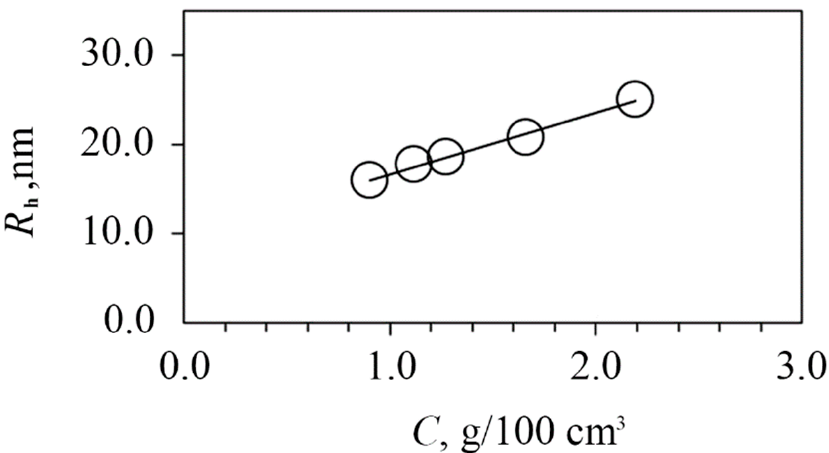
Figure 4. Hydrodynamic radii of dissolved species vs. concentration in 0.15 M NaCl for freshly synthesized